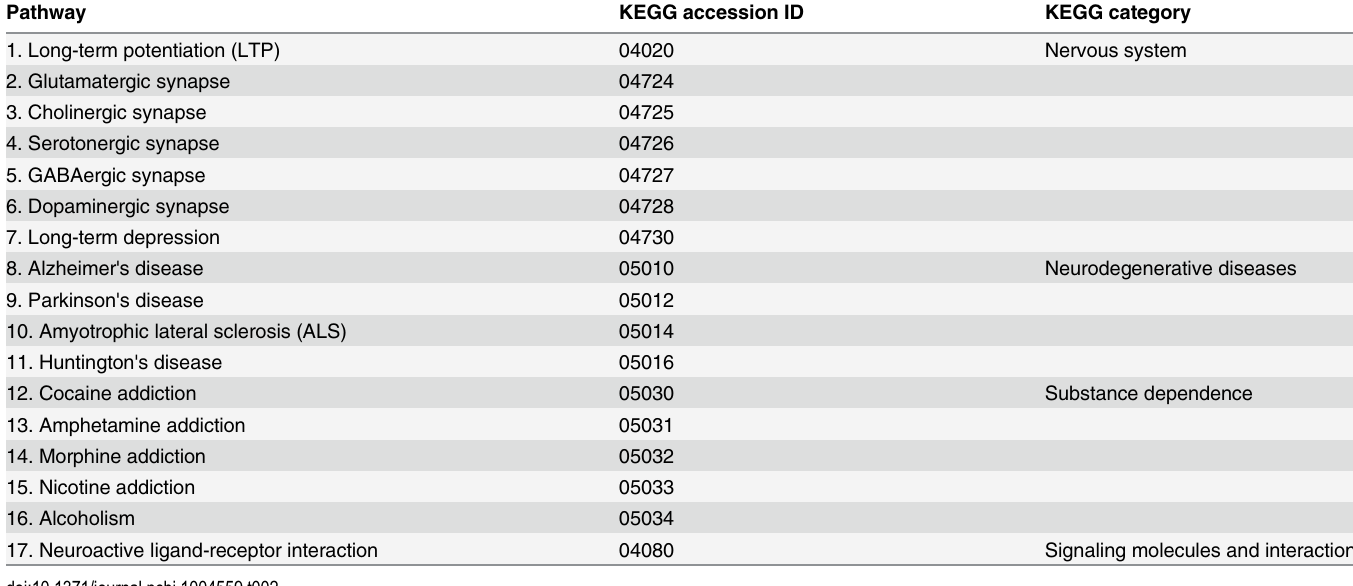
Table 2. List of KEGG brain-related pathways used to search for potential CDVs. Pathway KEGG accession ID KEGG